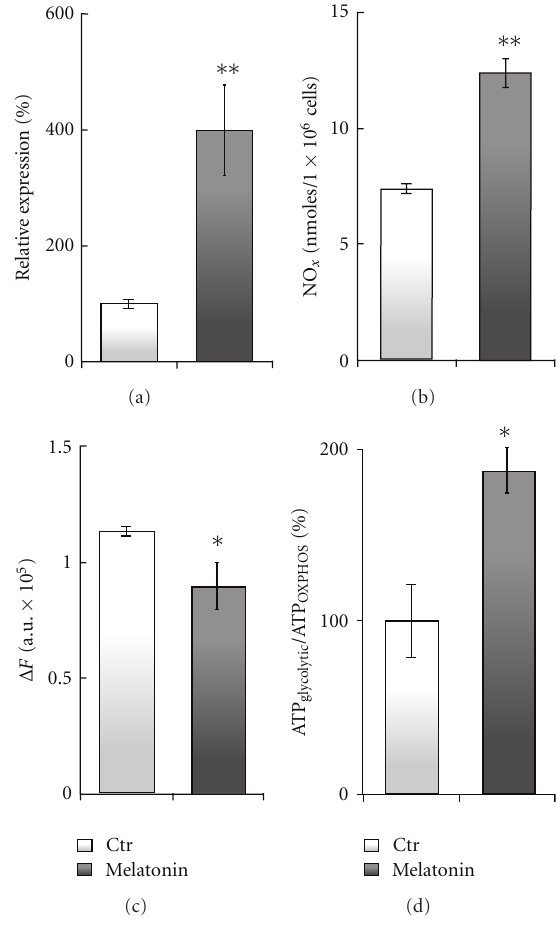
Figure 3: Melatonin-induced changes of the nNOS mRNA expres- sion in HaCaT cells: e ff ect on NO x production and mitochondrial membrane potential. (a)—Real-time PCR quantification of nNOS mRNA ( β -actin gene used for normalization). (b)—Fluorometric determination of the NO x release in the cell culture medium. (c)— Mitochondrial membrane potential evaluated as the fluorescence di ff erence, Δ F, from the maximal ( plateau ) to the minimal level reached after addition of valinomycin (see also Figure